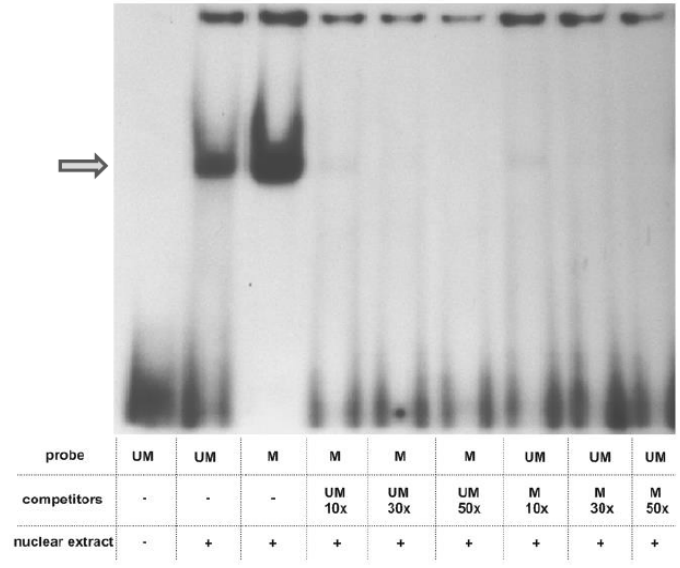
Figure 3. EMSA analysis. Nuclear extract of HaCaT cells (10 µg protein) was incubated with radioactively labelled probes containing the analyzed CpG in either an unmethylated or methylated form. Protein binding to each probe was competed with 10, 30 and 50 times excess of the other probe. The DNA-protein complex is indicated by an arrow.